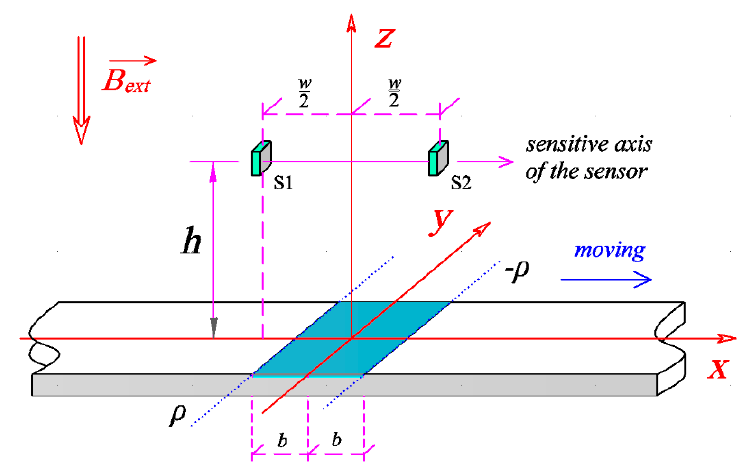
Figure 2. Measurement configuration with two active sensors S1 and S2. The two sensors locate at a liftoff h and with a gap w . The external magnetic induction is perpendicular to the strip surface.